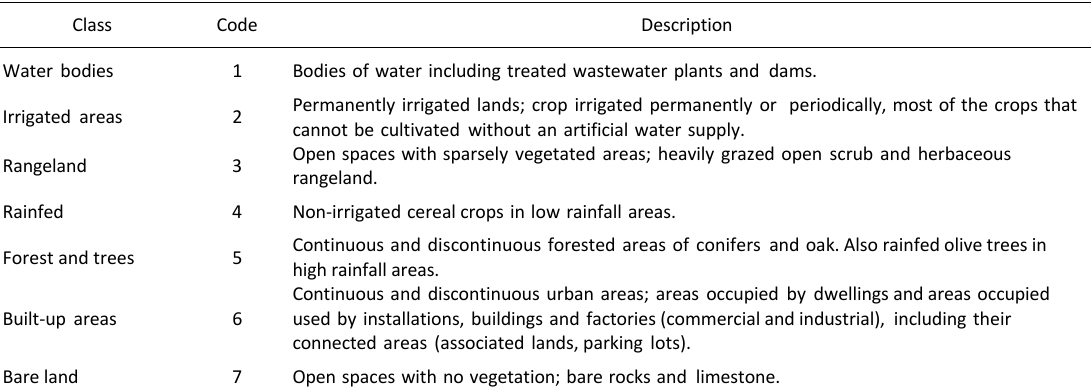
Fig. 2: The flow diagram of steps in simulating LULC changes Table 2: Land use/land cover classification scheme used in the study